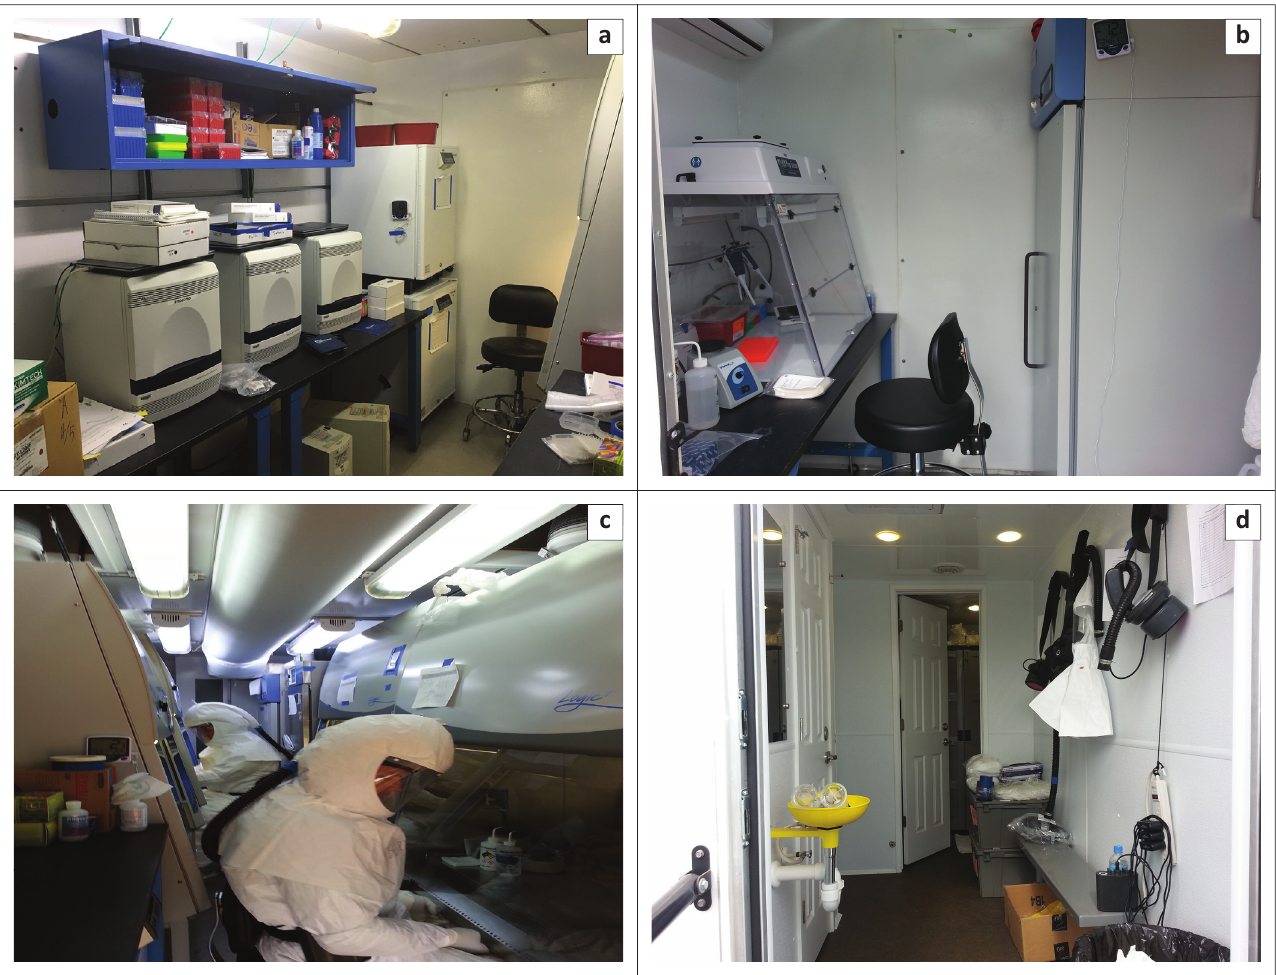
FIGURE 1: MRIGlobal mobile diagnostic laboratory that was deployed in response to the West Africa Ebola virus outbreak. (a) Interior of polymerase chain reaction laboratory unit. (b) Interior of master mix laboratory. (c) Interior of inactivation and extraction laboratory unit. (d) Interior of locker